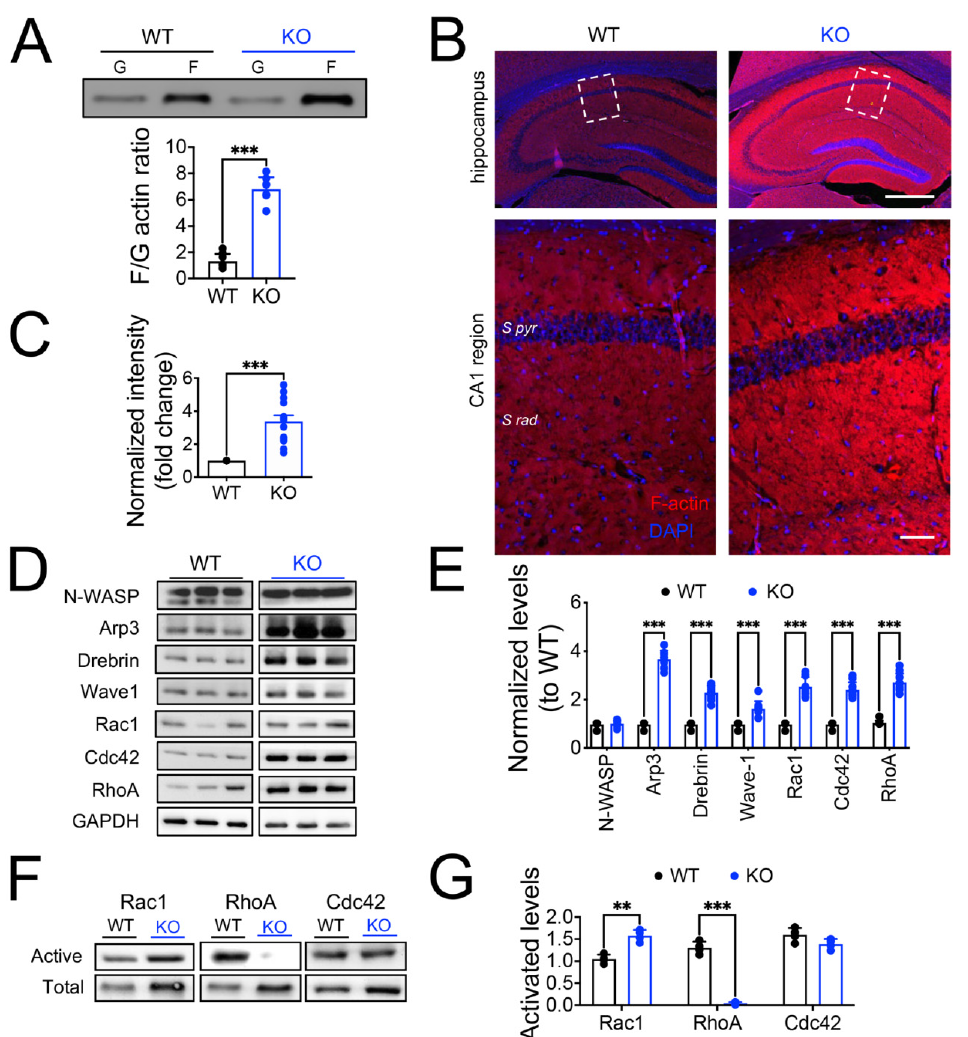
Figure 8. Increased actin polymerization and Rac1 activity in Panx1-KO hippocampi. ( A ) Representa- tive blots ( top ) and densitometric analysis of the relative amount of monomers ( G ) and filaments ( F ) of actin ( bottom ), in hippocampal lysates of WT ( black ) and Panx1-KO (KO, blue ) mice. n = 6 (WT) and n = 6 (KO) slices from 4–5 animals, *** p < 0.001 Mann–Whitney test. ( B ) Representative con- focal micrographs showing the rhodamine-phalloidin reactivity of the F-actin network in the CA1 region in the hippocampus. Whole hippocampal at 4X magnification ( top panel ), scale bar: 150 µ m. Magnified view showing the Stratum radiatum ( Sr ) and the Stratum pyramidale ( Sp ) layer at 20X magnification ( bottom panel ), scale bar: 25 µ m. ( C ) Quantification of rhodamine-phalloidin intensity. n = 6 (WT) and n = 6 (KO) slices from 6 animals, *** p < 0.001 Mann–Whitney test. ( D , E ) Represen- tative blots ( D ) and densitometric analysis ( E ) of Rho GTPases and synaptic actin-binding proteins levels. n = 6 (WT) and n = 6 (KO) slices from 6 animals, *** p < 0.001 two-way ANOVA test. ( F , G ) Rep- resentative blots ( F ) and densitometric analysis ( G ) of the relative levels of the active Rac1, Cdc42 and RhoA proteins. n = 6 (WT) and n = 6 (KO) slices from 6 animals, ** p = 0.02, *** p < 0.001 two-way ANOVA